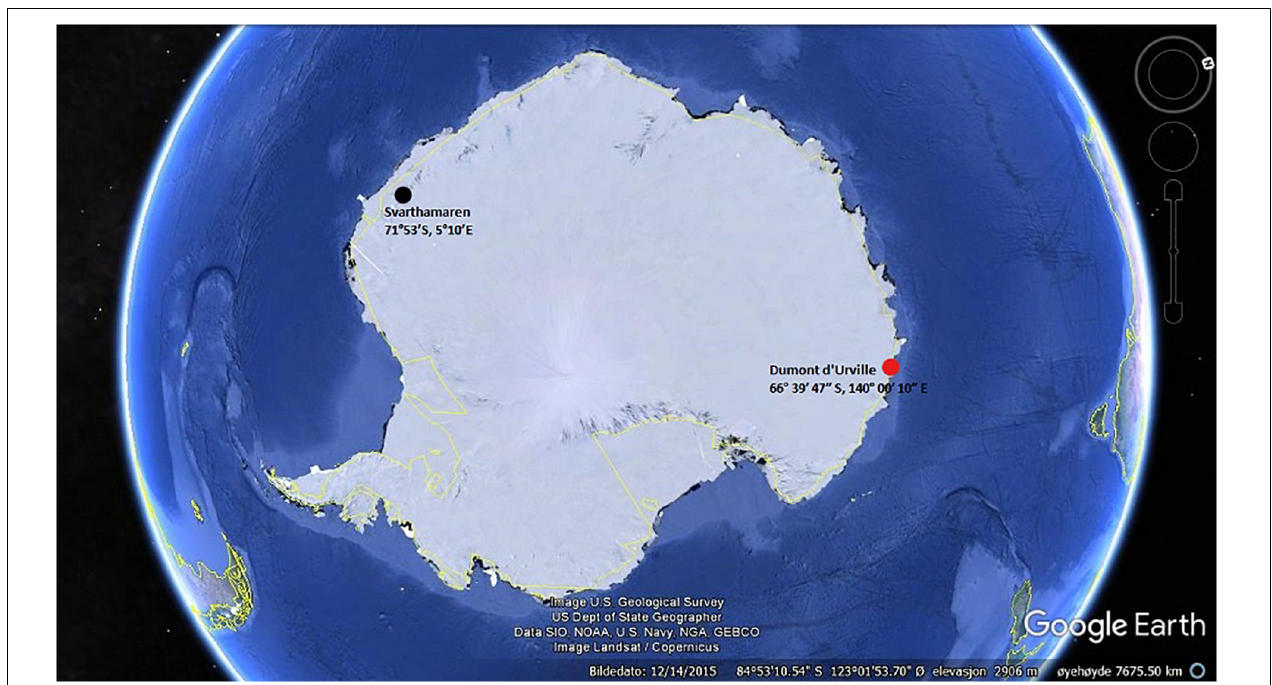
FIGURE 1 | Antarctica with the study sites of Svarthamaren in Dronning Maud Land and Dumont d’Urville in Adélie Land marked. Source Google maps.